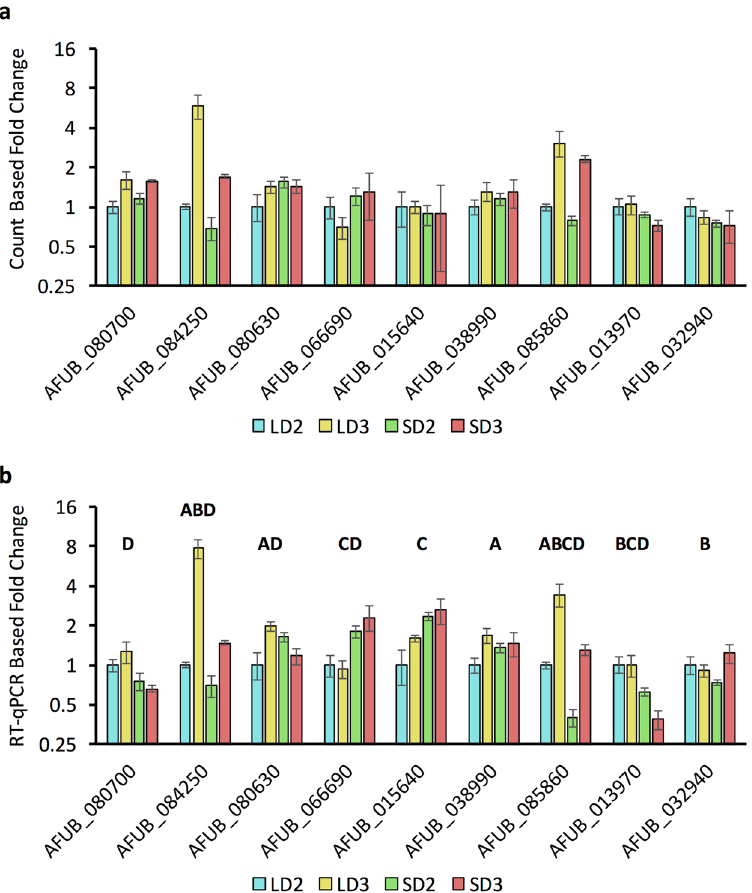
Figure 9. RT-qPCR analysis of A. fumigatus genes expressed during chemotherapeutic and steroid treatment mouse models of invasive pulmonary aspergillosis on day 2 and 3 post inoculation. Fold change was determined for expressed putative A. fumigatus secreted proteins via ( a ) Count based analysis and ( b ) RT-qPCR analysis. Fold-change was normalized for RT-qPCR using β -tubulin and TefA , and presented in relation to LD2 gene expression (comparator) using the ΔΔ CT method. For count based analysis data is presented in relation to LD2 gene expression (comparator). Statistical significance is indicated for instances where p < 0.05. A/B statistically significant differential expression between day 2 and day 3 for the chemotherapeutic/steroid model respectively. C/D, statistically significant differentially expression between the chemotherapeutic and steroid model for day 2/day 3 respectively. Standard deviation from the mean is presented. Steroid Model, S; Chemotherapeutic Model, L; Day 2, D2; Day 3,